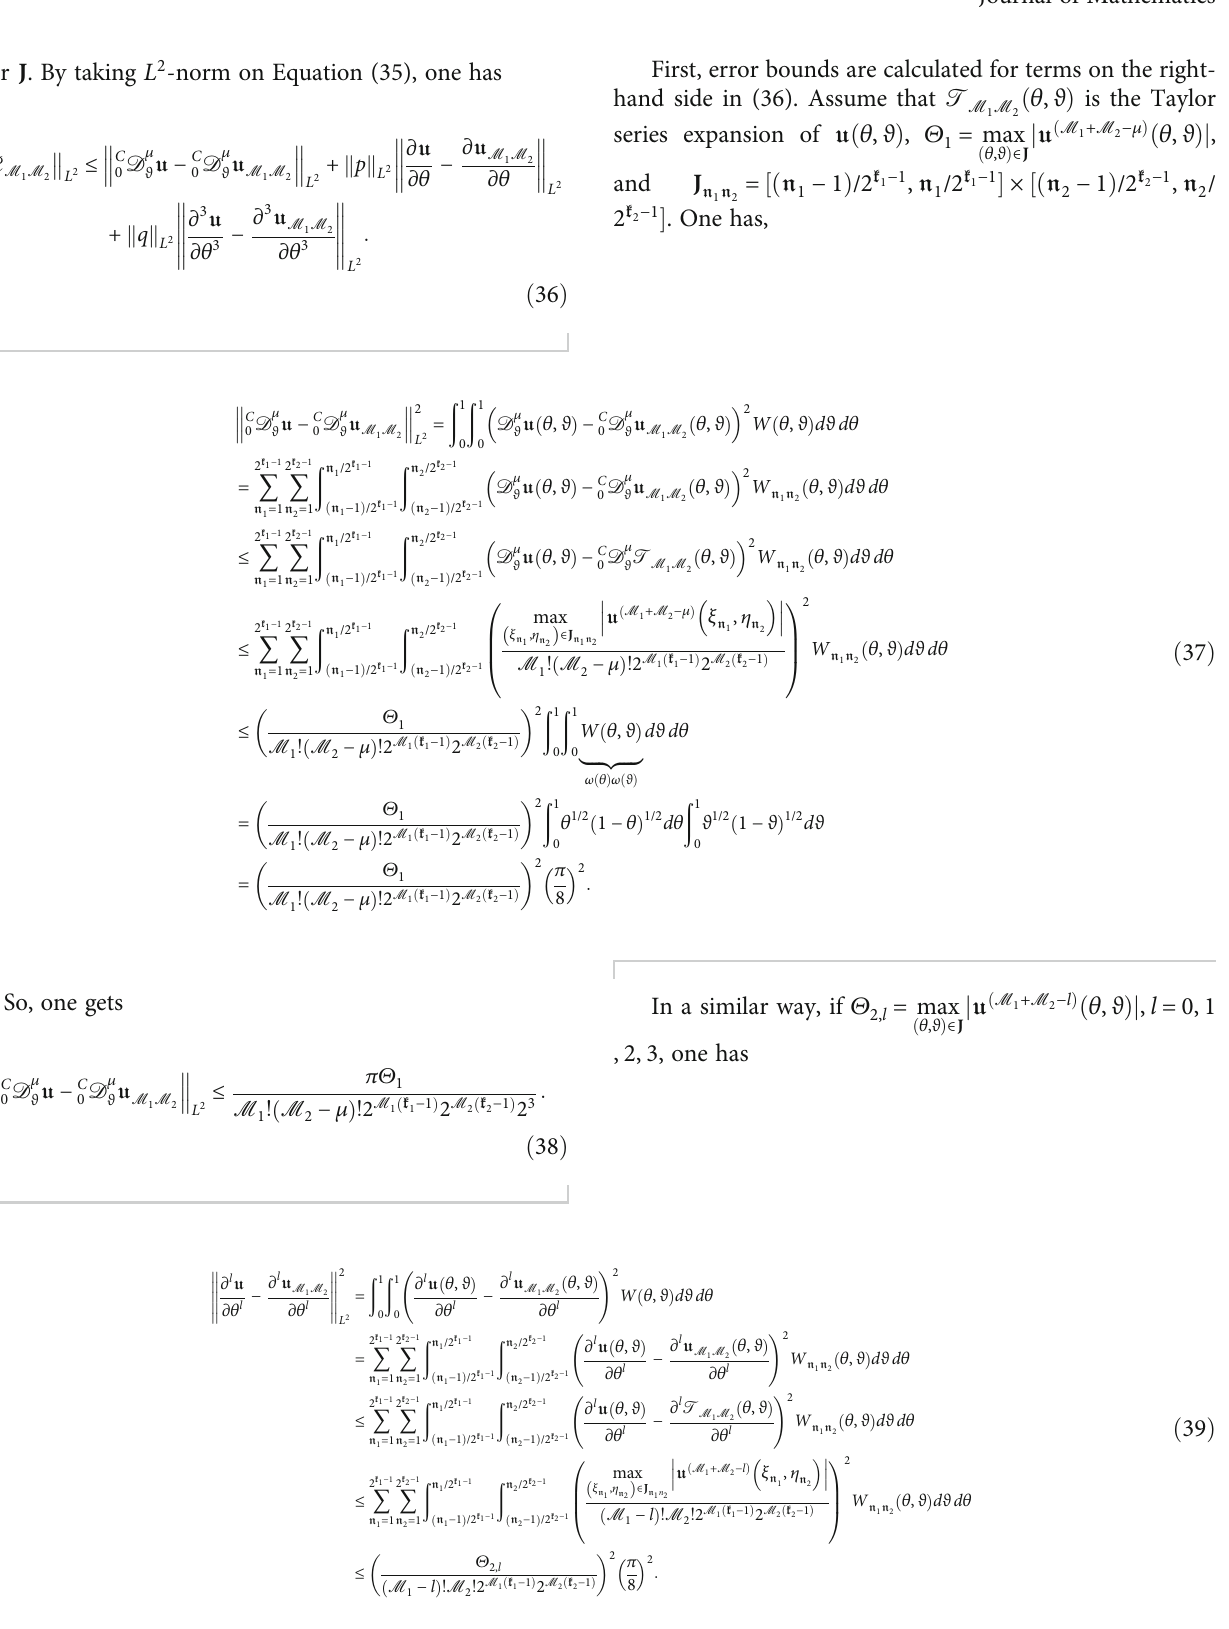
ð θ , ϑ Þ is the 1 M 2